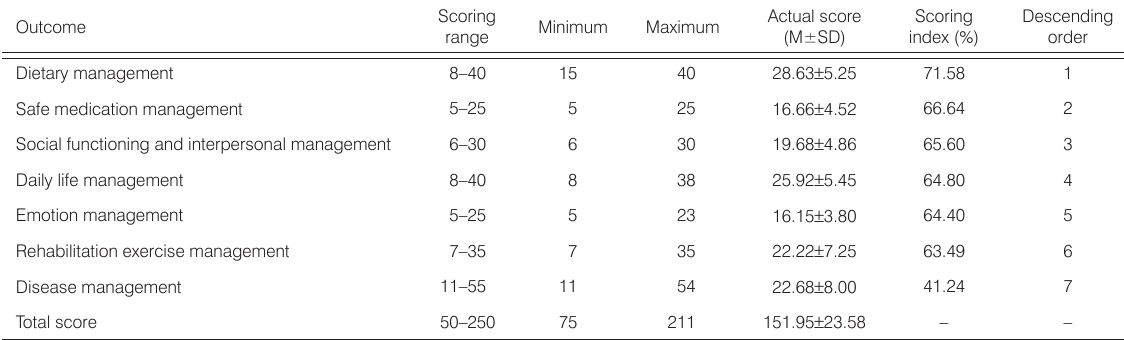
Table 1. Scores of self-management dimensions in the stroke recovery stage ( n =440).